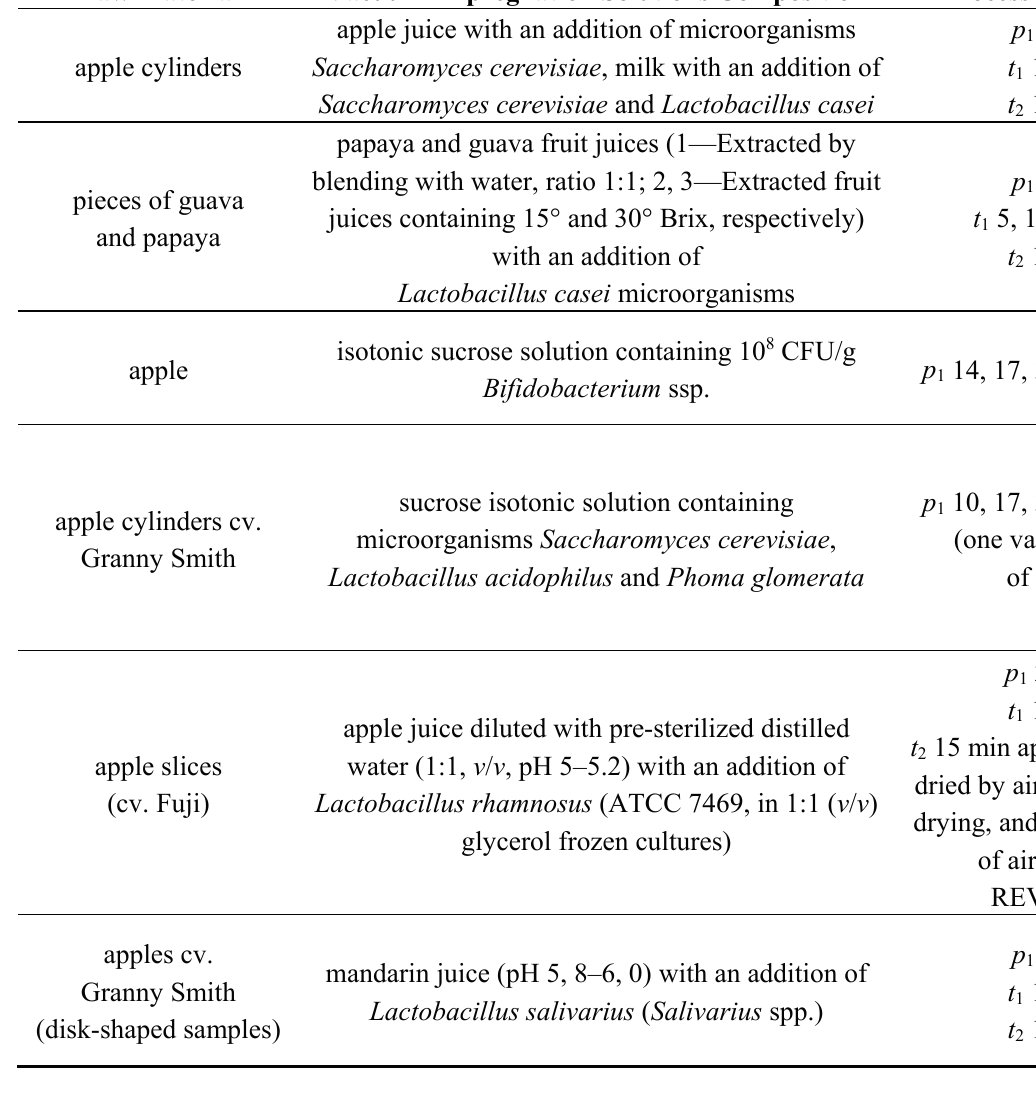
Table 2. Examples of applications of vacuum impregnation to modify health-promoting properties of fruit and vegetable products. Raw